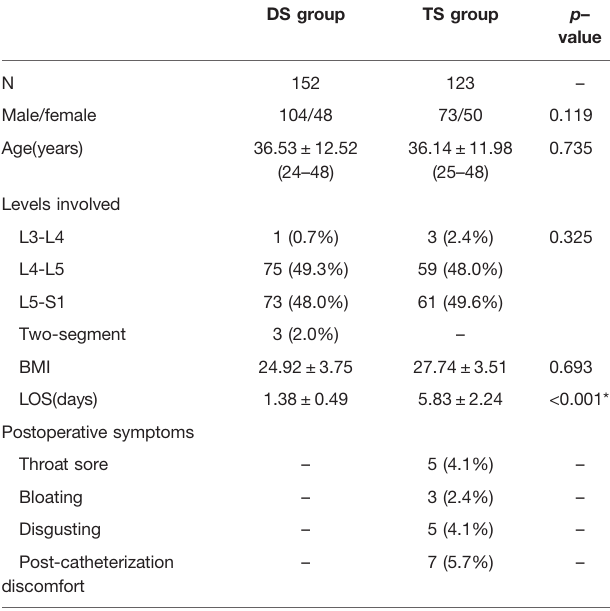
TABLE 1 | General